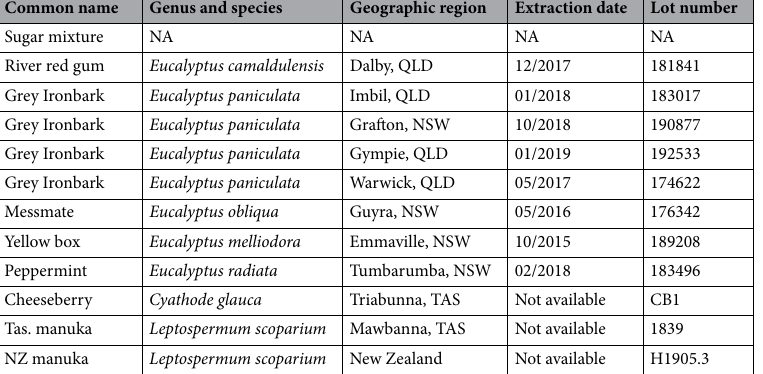
Table 1. Honey samples used in the study. NA, not applicable; QLD, Queensland; NSW, New South Wales; TAS, Tasmania.